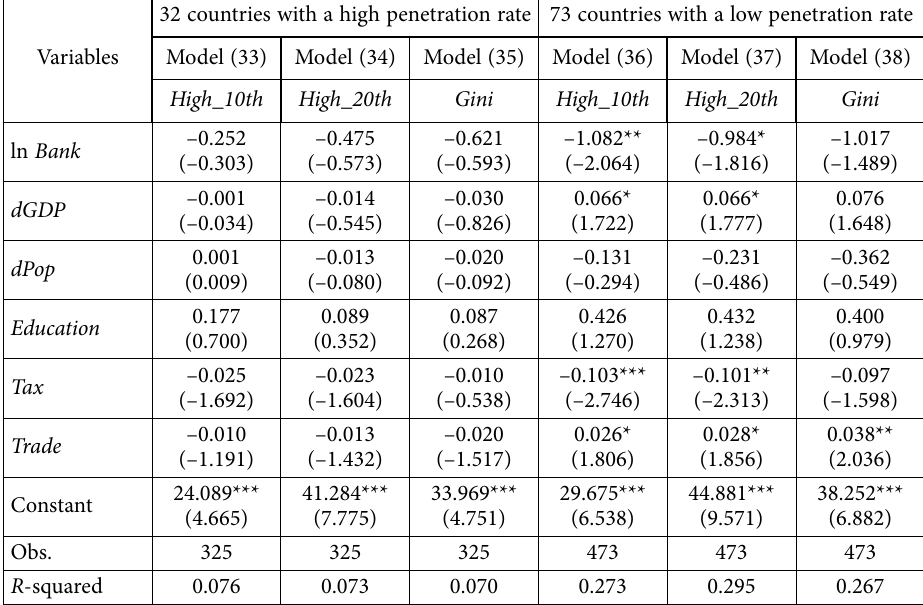
Table 9. Results of sub-samples classified by penetration rates of mobile payment accounts